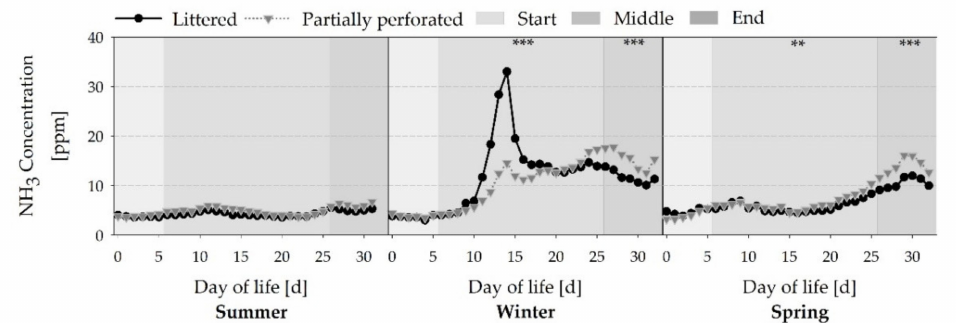
Figure 6. Average daily ammonia (NH 3 ) concentrations from broiler houses with two different floor types measured over three different fattening periods ( n = 480 values per day and barn). Significant differences between both floor types within the three different sections (start, middle, end of the fattening period) are marked by asterisks: ** p < 0.01, *** p <